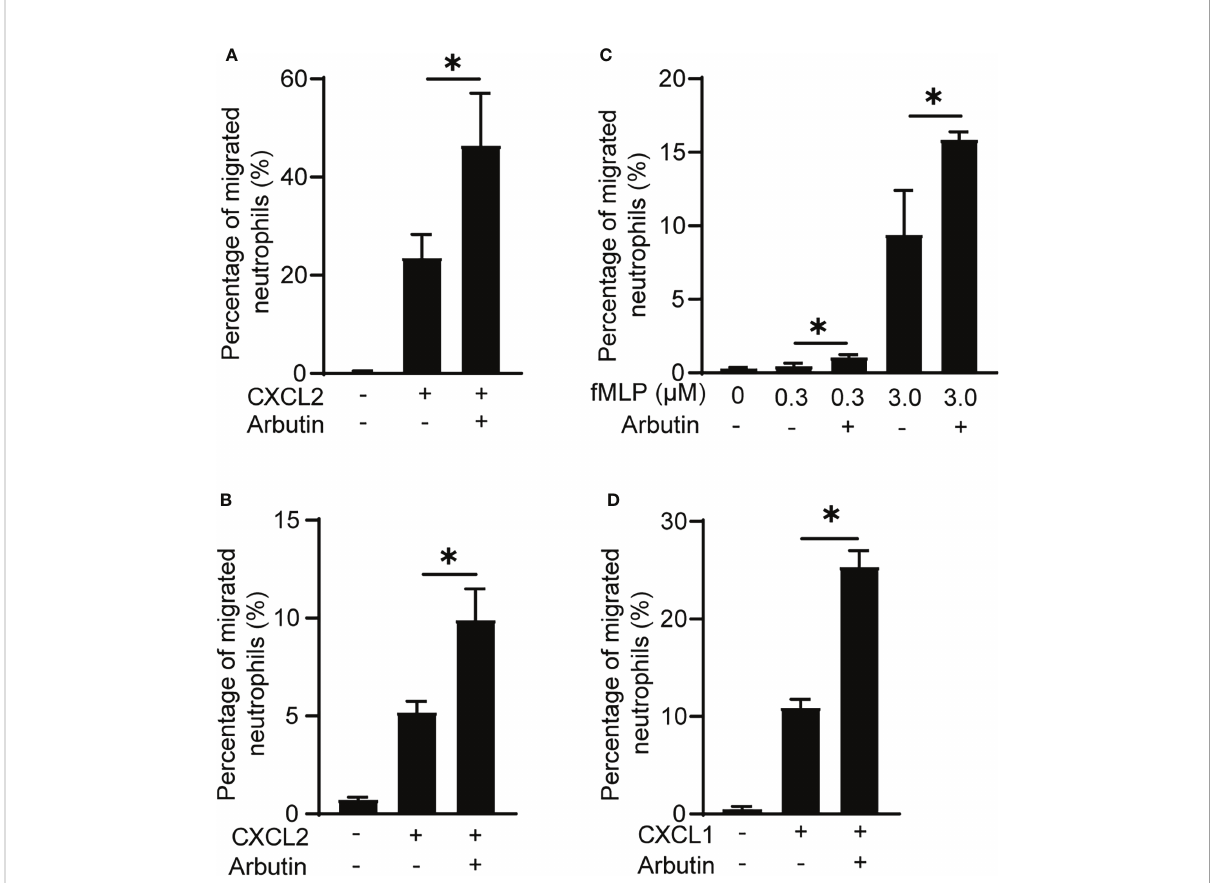
FIGURE 3 Arbutin enhances neutrophil migration. (A, B) Effects of arbutin on puri fi ed neutrophil (A) or peritoneal neutrophil (B) migration to CXCL2 was assessed by Transwell assay. Data are presented as the mean ± SD of triplicates from one experiment and are representative of two independent experiments. * p < 0.05 by Student ’ s t test. (C, D) Neutrophil migration in response to fMLP (C) or CXCL1 (D) with or without arbutin was evaluated by Transwell assay. Data are presented as the mean ± SD of triplicates from one experiment and are representative of two independent experiments. * p < 0.05 by Student ’ s t